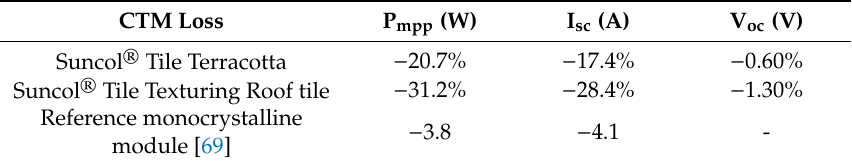
Table 4. CTM loss in Suncol ® Tile Terracotta and Texturing Roof tile